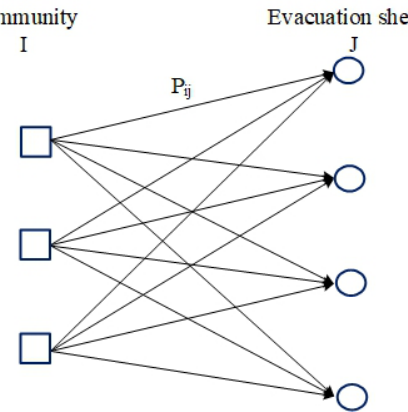
Figure 1. Schematic diagram of community evacuation route